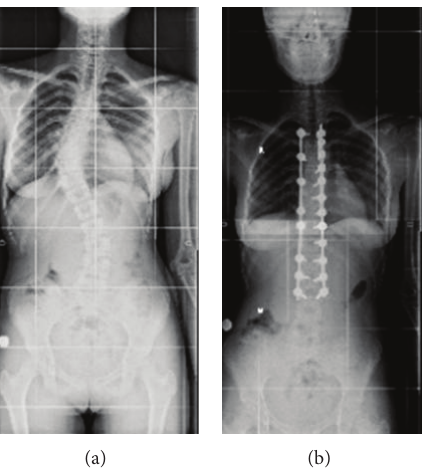
Figure 1: (a) Using preoperative radiography, thoracic scoliosis with right curvature was observed. (b) Postoperative radiography showing complete resolution of the spinal curvature after surgery.